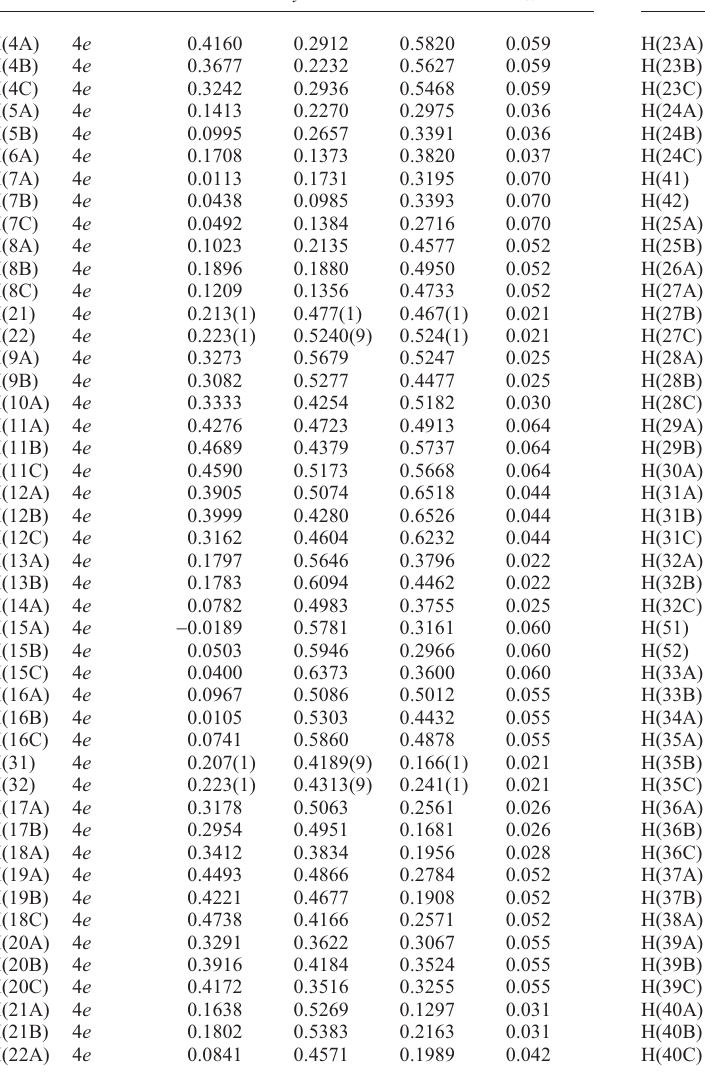
Table 3. Atomic coordinates and displacement parameters (in Å 2 )